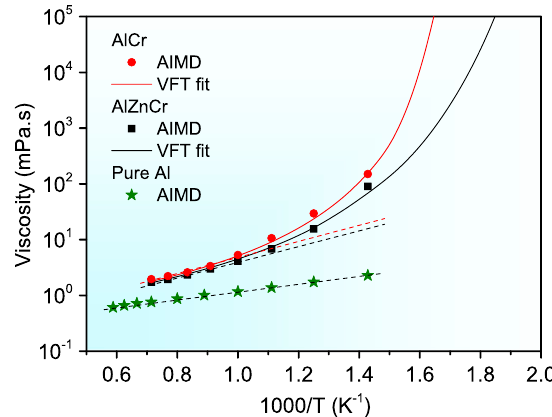
Fig. 2 Arrhenius plot of the α -structural relaxation time of Al and Cr atoms for Al − Cr binary alloy and Al, Zn, and Cr atoms for Al − Zn − Cr ternary alloy. The simulation data for pure liquid Al is also included for comparison. The dashed and solid lines correspond to the VFT fi t of the α -structural for Al − Cr binary alloy and Al − Zn − Cr ternary alloy, respectively. Arrhenius fi ts in the temperature range 1400 − 1000 K for Al − Cr ( dashed - dotted lines ) and Al − Zn − Cr ( dashed - double-dotted lines )